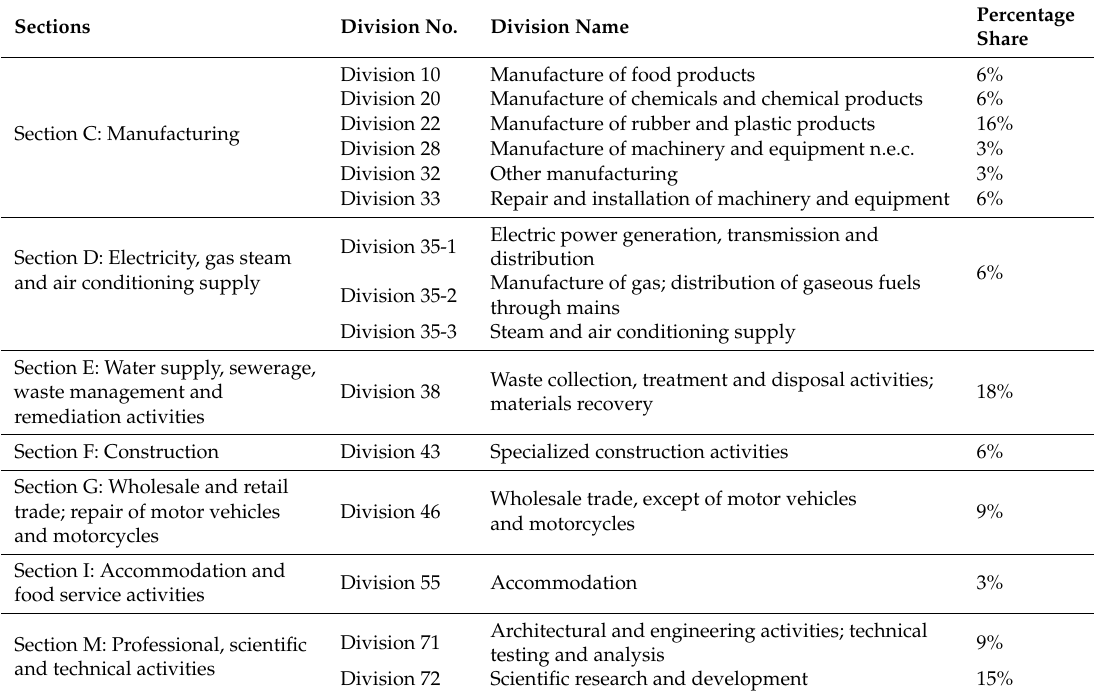
Table 1. Profile of companies participating in the study according to the PKD code